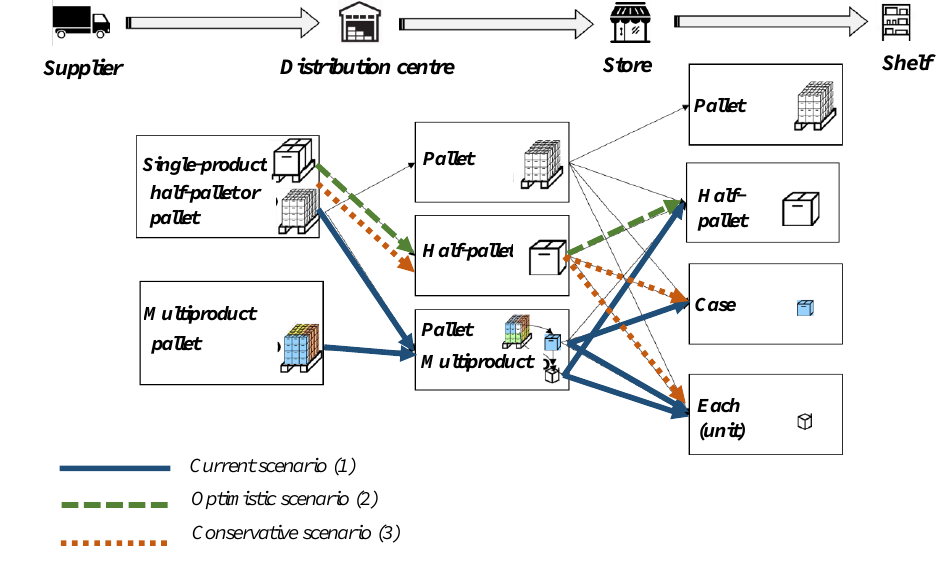
Figure 2. Scenarios considered in the study of the handling unit